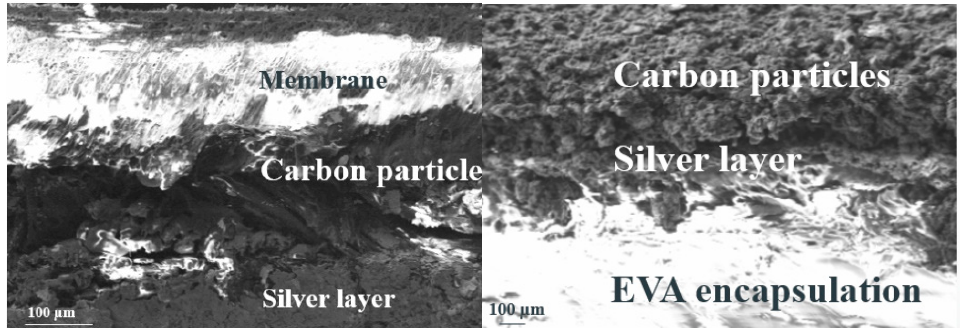
Figure 2. Cross-sectional SEM view of the ( left ) carbon black electrodes, silver layer on top of tex- tile (with membrane), ( right ) EVA encapsulation